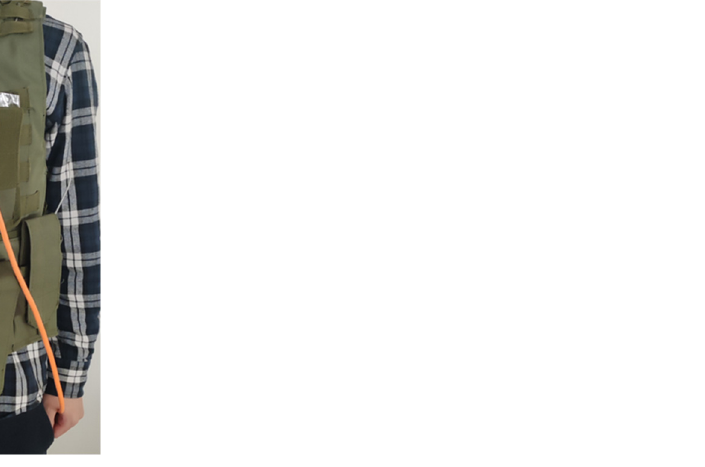
Figure 4. Data Acquisition. The IMU data collected on the wearable are the training set, and the data collected by the camera device are the ground truth